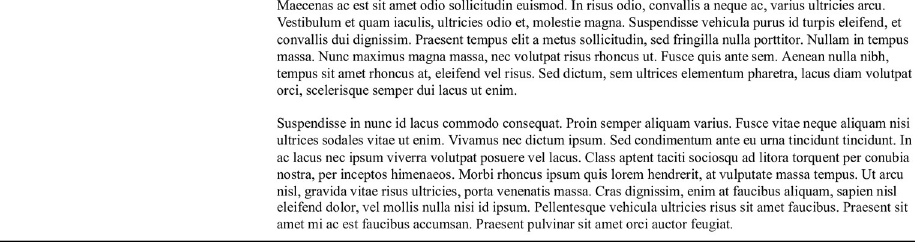
Fig 1. (a) 3D printed master model and abbreviations for each abutment, (b) Stone model fabricated with BC stone, (c) Stone model fabricated with EM resin-reinforced stone, (d) Stone model fabricated with conventional type IV ERF